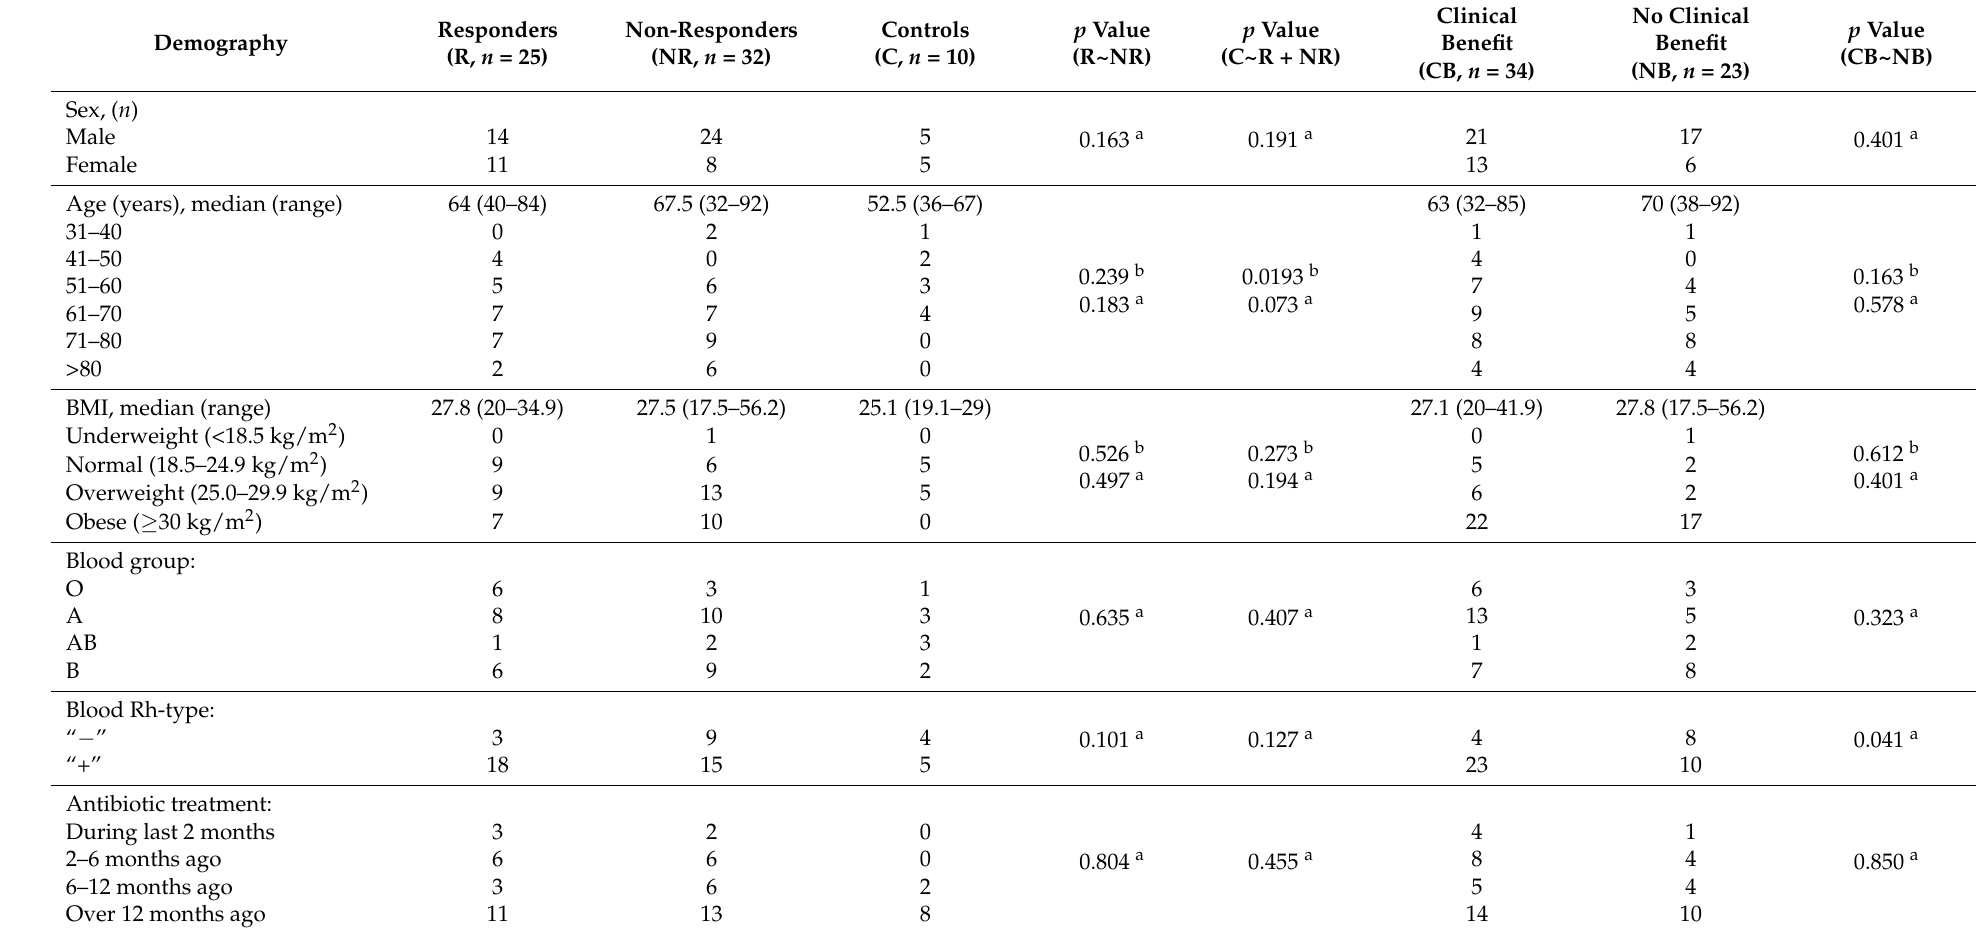
Table 2. Summary of the socio-demographic and dietary characteristics of study